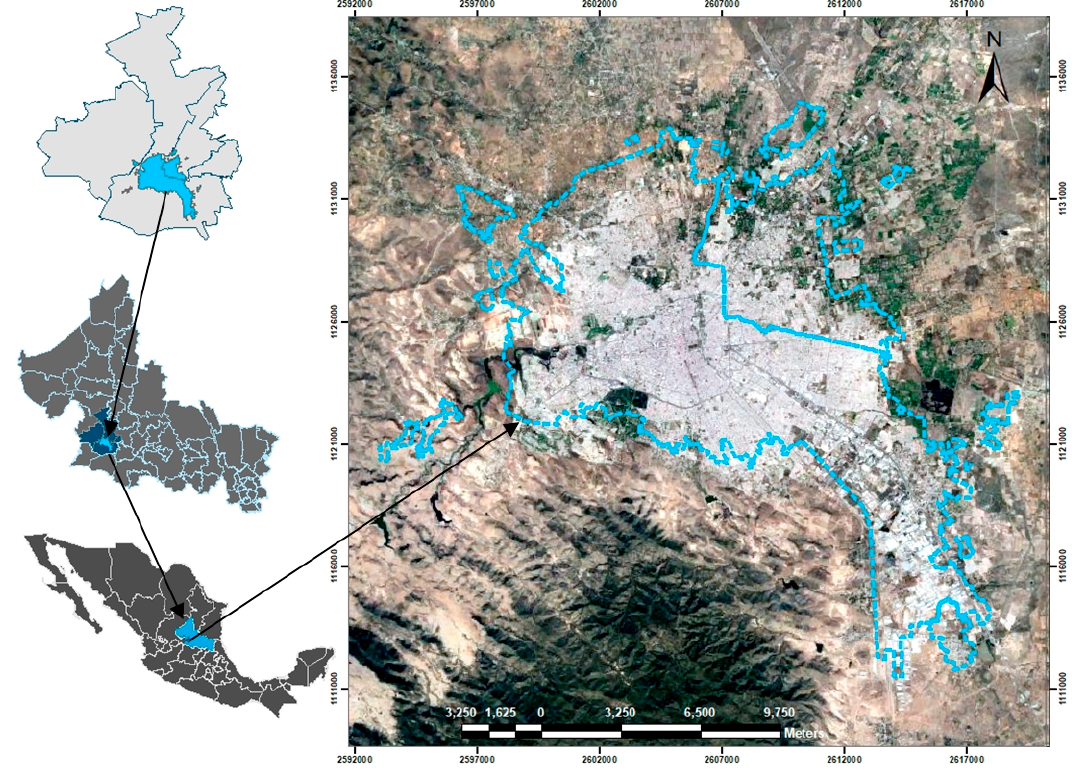
Figure 1. Location of San Luis Potosí.